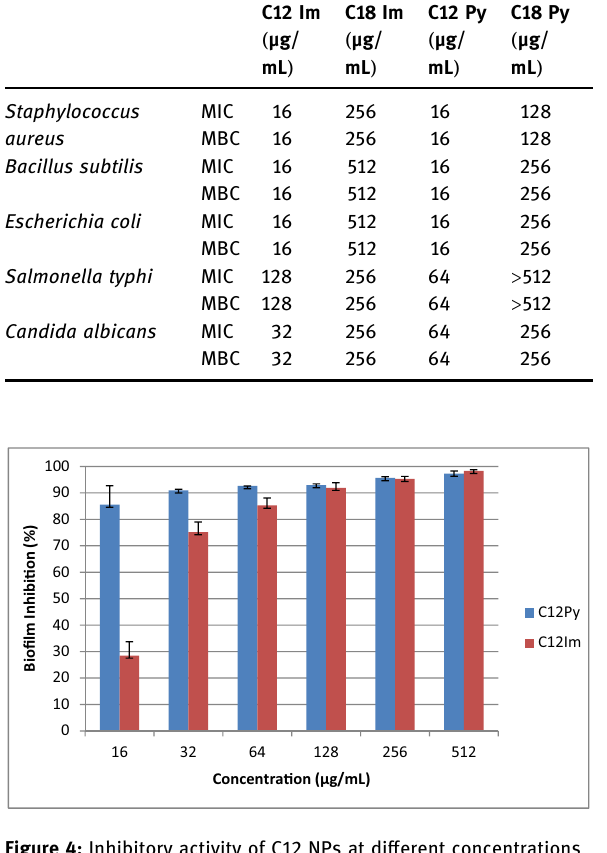
Figure 7: Inhibitory activity of C12 NPs at di ff erent concentrations against the bio fi lm formation of Enterococcus faecalis in 48 h.